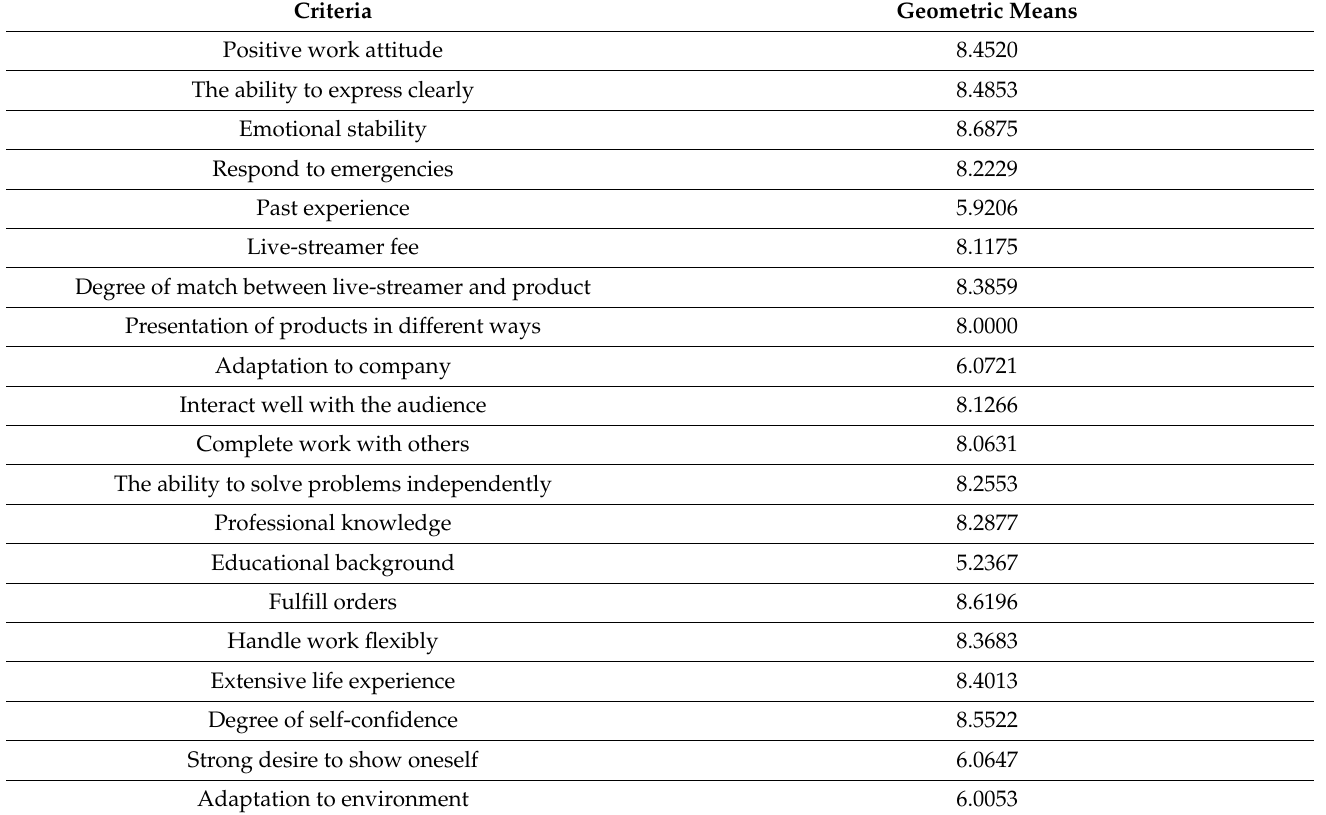
Table 1. Results of the fuzzy Delphi